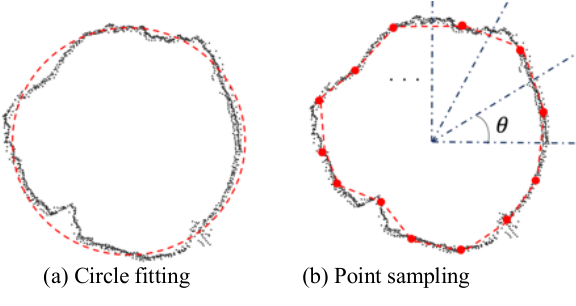
Figure 8. Sampling points on section shape